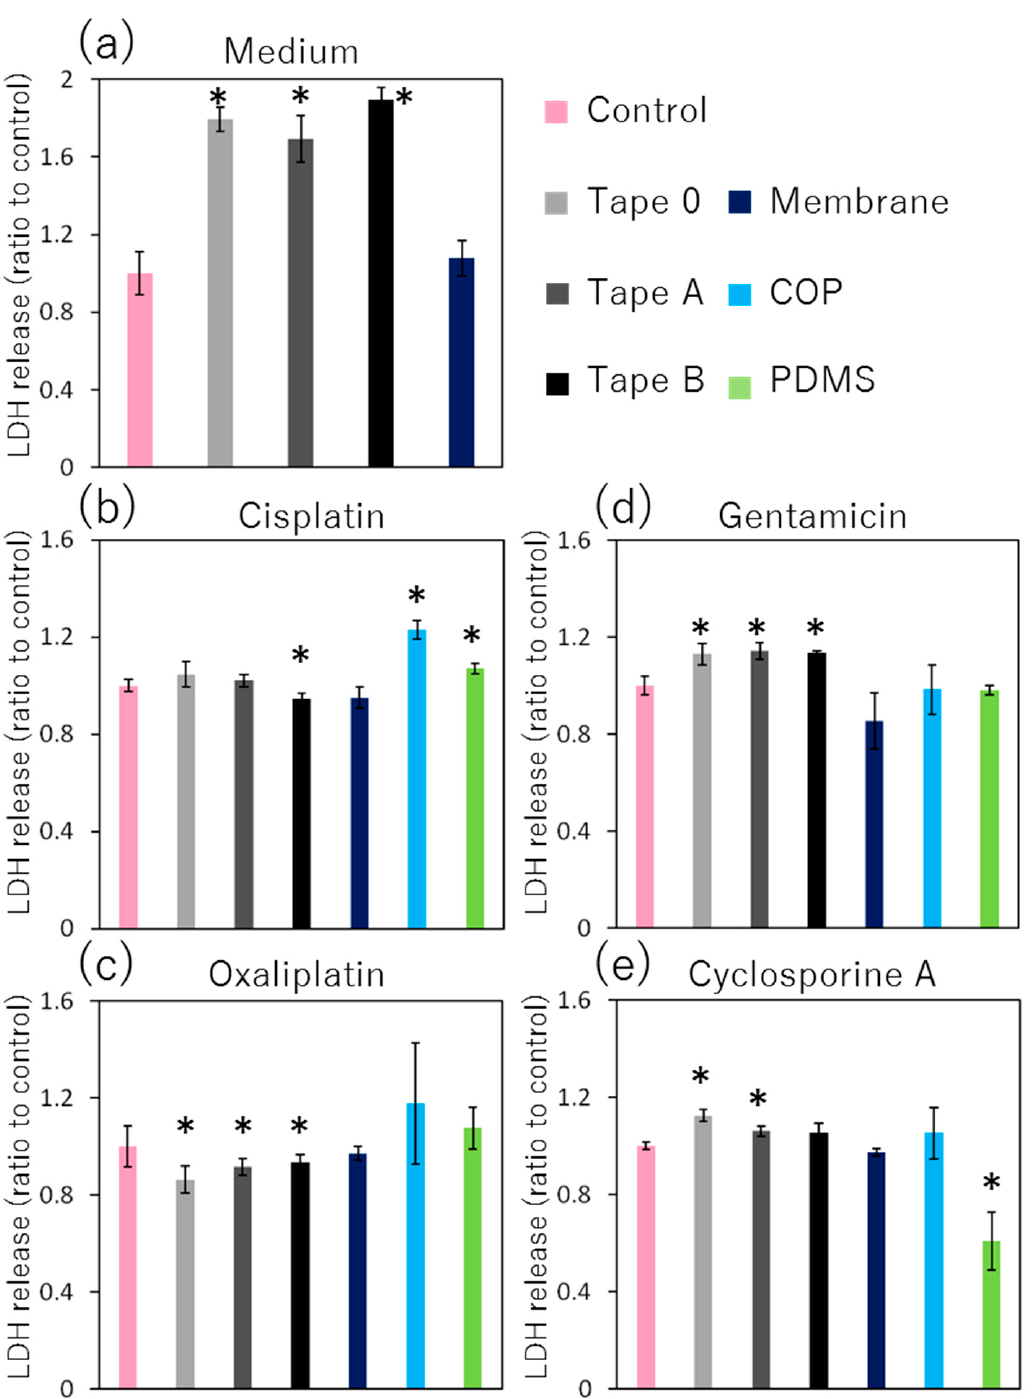
Figure 3. Cytotoxicity and drug adsorptivity of each material estimated by LDH release. Data are presented as mean ± SD (technical replicates, n = 3). * p < 0.05 against control. ( a ) Medium; ( b ) Cisplatin; ( c ) Oxaliplatin; ( d ) Gentamicin; ( e ) Cyclosporine A.